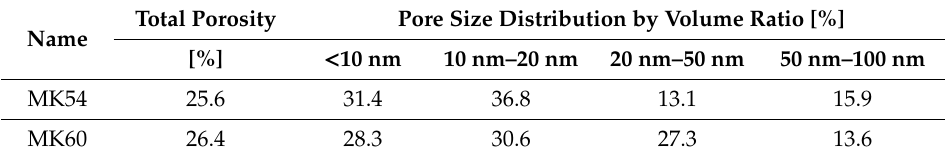
Table 2. Total Hg intruded porosity and percentage of pore sizes (MIP) for MK54 and MK60 after 28 days of ambient curing (21 ◦ C, 50%